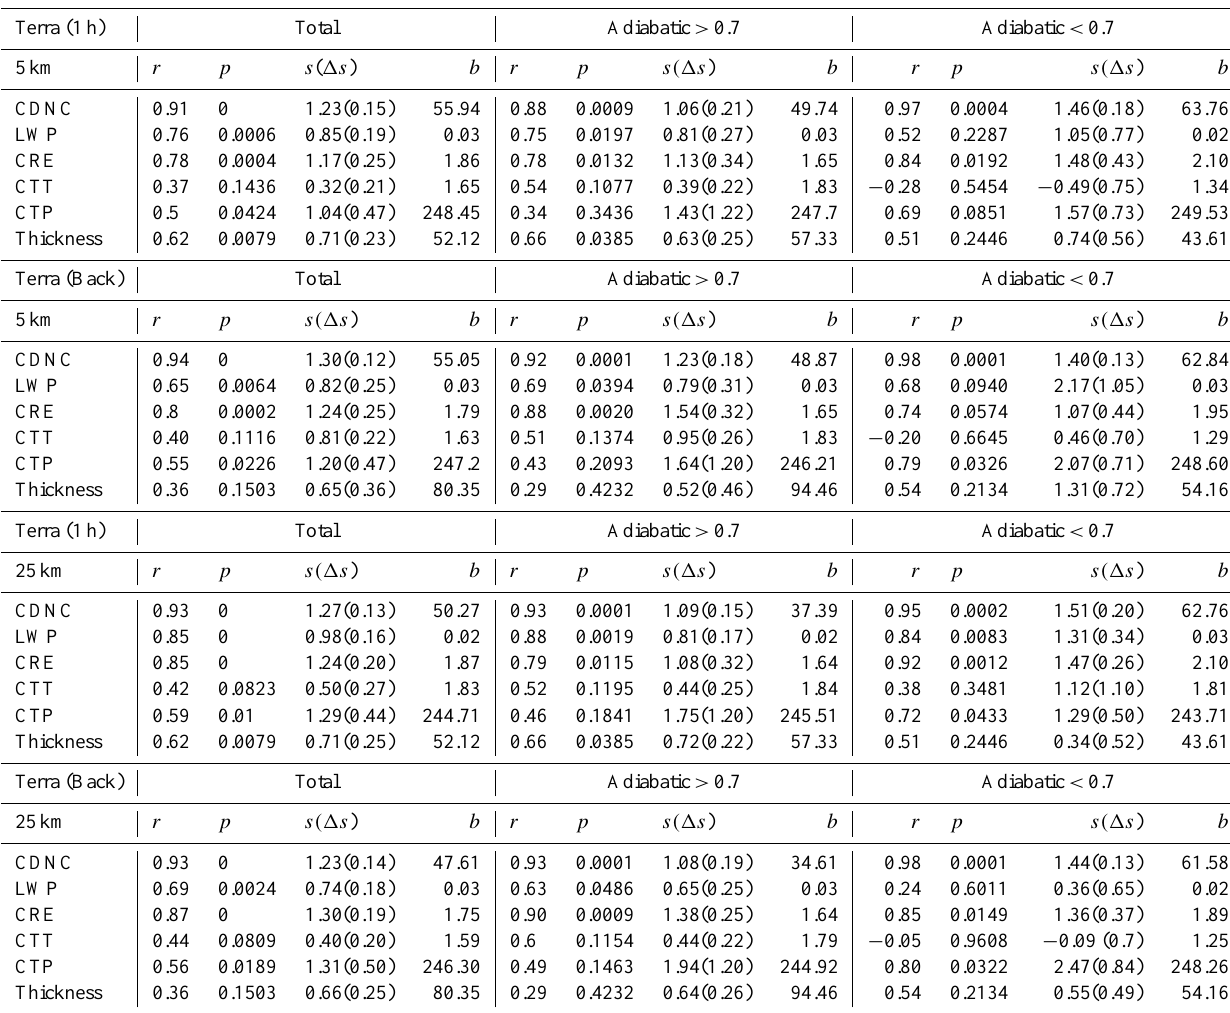
Table 3. Statistics of comparison of MODIS retrievals with aircraft measurements for both projected and un-projected positions at both 5 and 25 averaging domains, r , p , s ( 1s ), and b are the correlation coefficient, the probability p-value, the slope of linear fit (standard deviation of the slope), and the bias,